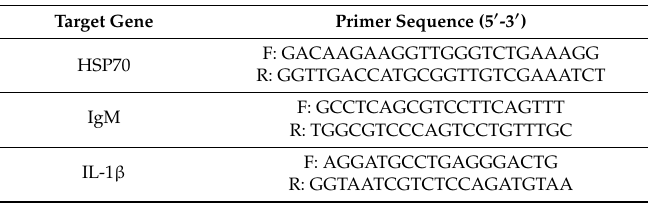
Table 2. Sequences of primers for Real-time